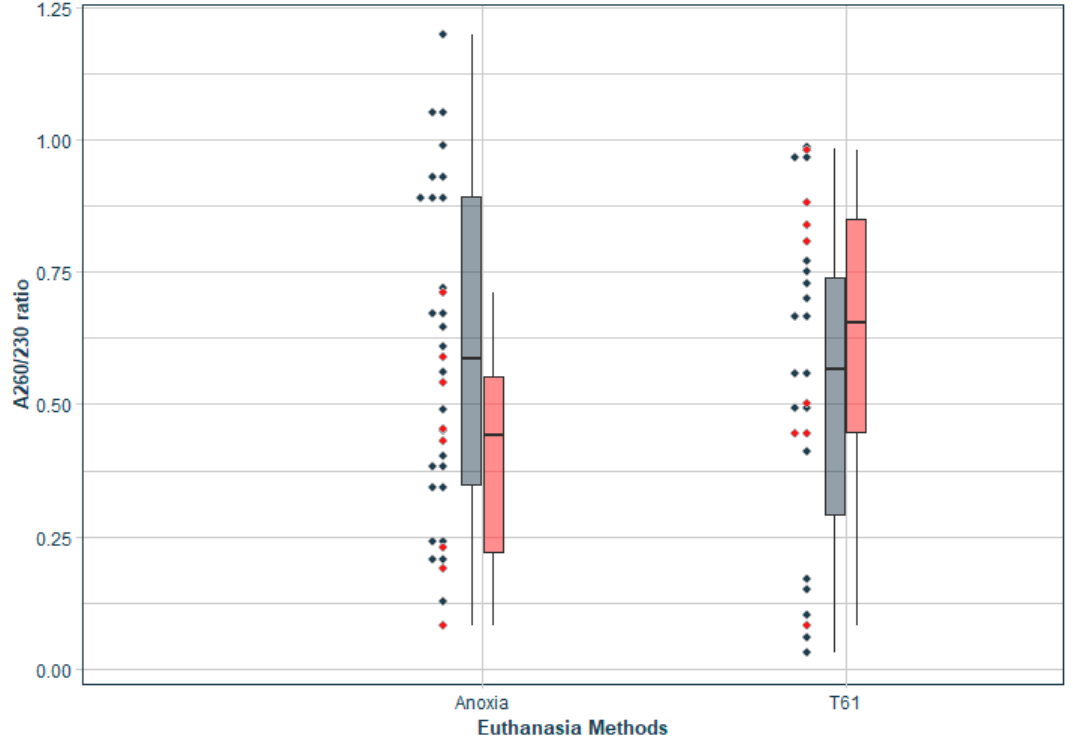
Figure 2. Details of discarded samples grouped based on euthanasia method and storage conditions is plotted here. Black dots represent the samples stored in LN 2 , and red dots represent the samples stored in RNA later TM . Samples stored in LN 2 ( n = 47) were the majority (~75%) of samples that were discarded compared to RNA later TM storage ( n = 16).